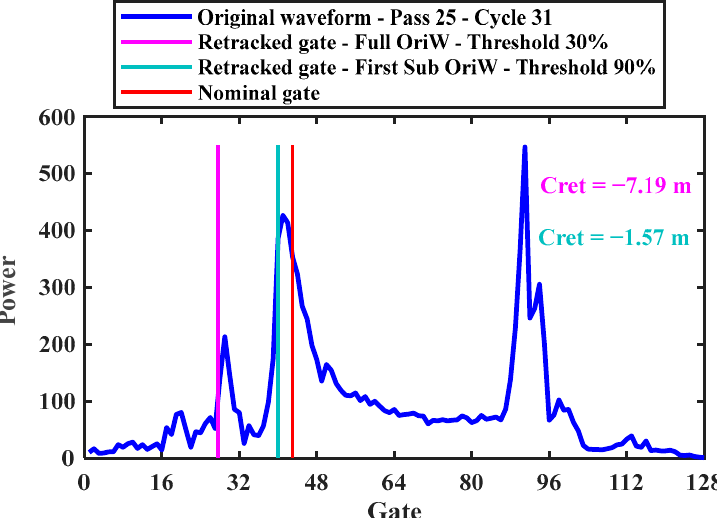
Figure 6. Retracked gates obtained from the full-waveform and the first sub-waveform of pass 25 cycle 31 over the Persian Gulf.